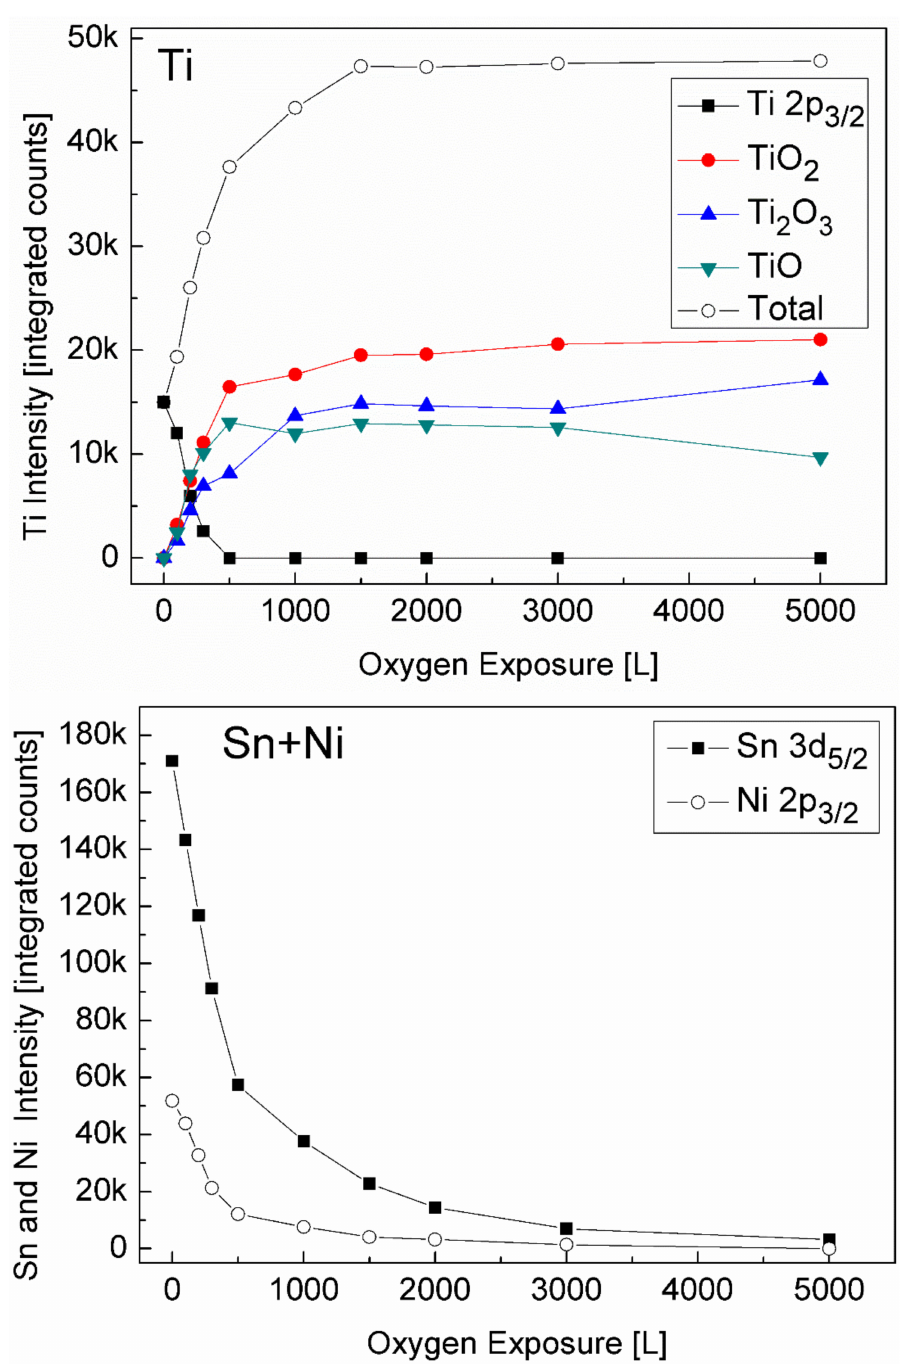
Figure 8. Intensity variation of the Ti and its oxides and of the Ni and Sn during oxygen exposure at 1000 K. The O1s spectra (Figure 10), taken after 5000 L at RT and 1000 K, show some asymmetrical peaks, with BE that increase from 530.1 eV at RT up to 530.7 eV at 1000 K. The asymmetry probably stems from the variety of titanium oxides present, and the shift to higher energy at 1000 K is probably due to the more crystalline nature of the oxide formed at the elevated temperature and from the existence of TiO